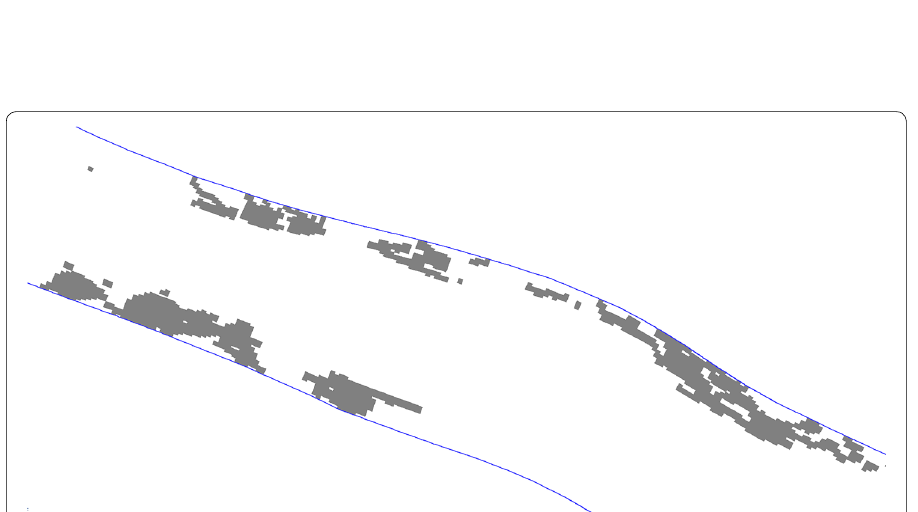
Fig. 7 Section of the computational domain (plan view). Grey shaded cells indicate cells where slides occur. The blue lines represent the sides of the